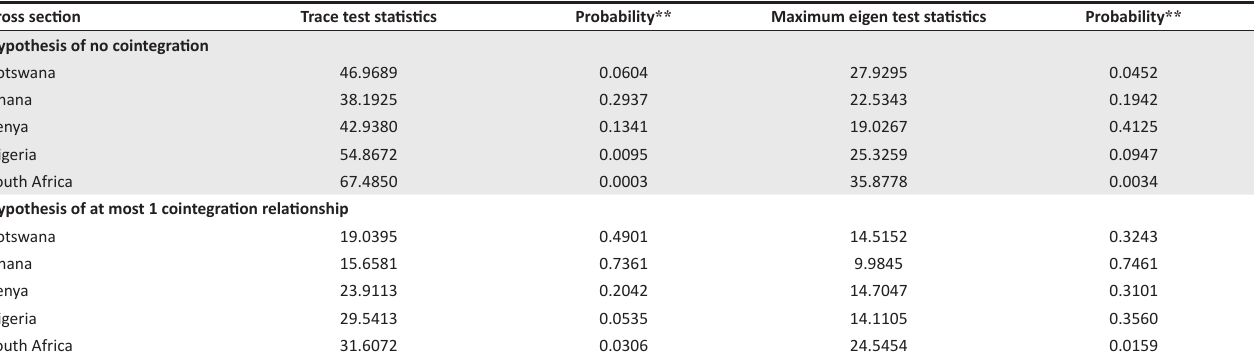
TABLE 4: Individual cross section results, 1980–2014.